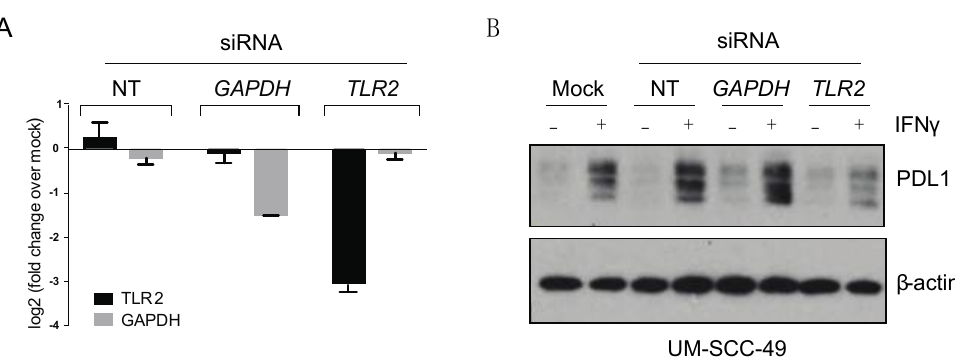
Figure 3. TLR2 depletion attenuates IFNγ-mediated upregulation of PDL1 in UM-SCC-49 cells. ( A ) UM-SCC-49 cells were treated with siRNA as indicated, and knockdown of TLR2 and GAPDH RNA expression was tested by qPCR. ( B ) Cells were transfected with non-targeting (NT), GAPDH, or TLR2 siRNA for 24 h were then treated −/+ 10 ng/mL IFNγ for 48 h, and protein expression was assessed by immunoblot as indicated. The uncropped Western blots have been shown in Figure S3.”.